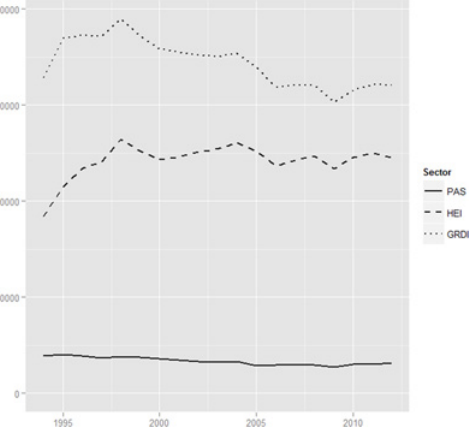
Fig 2. R&D staff, according to PPSS sector, shown in Full Time Equivalents (FTE); data displays cumulative, three-year moving